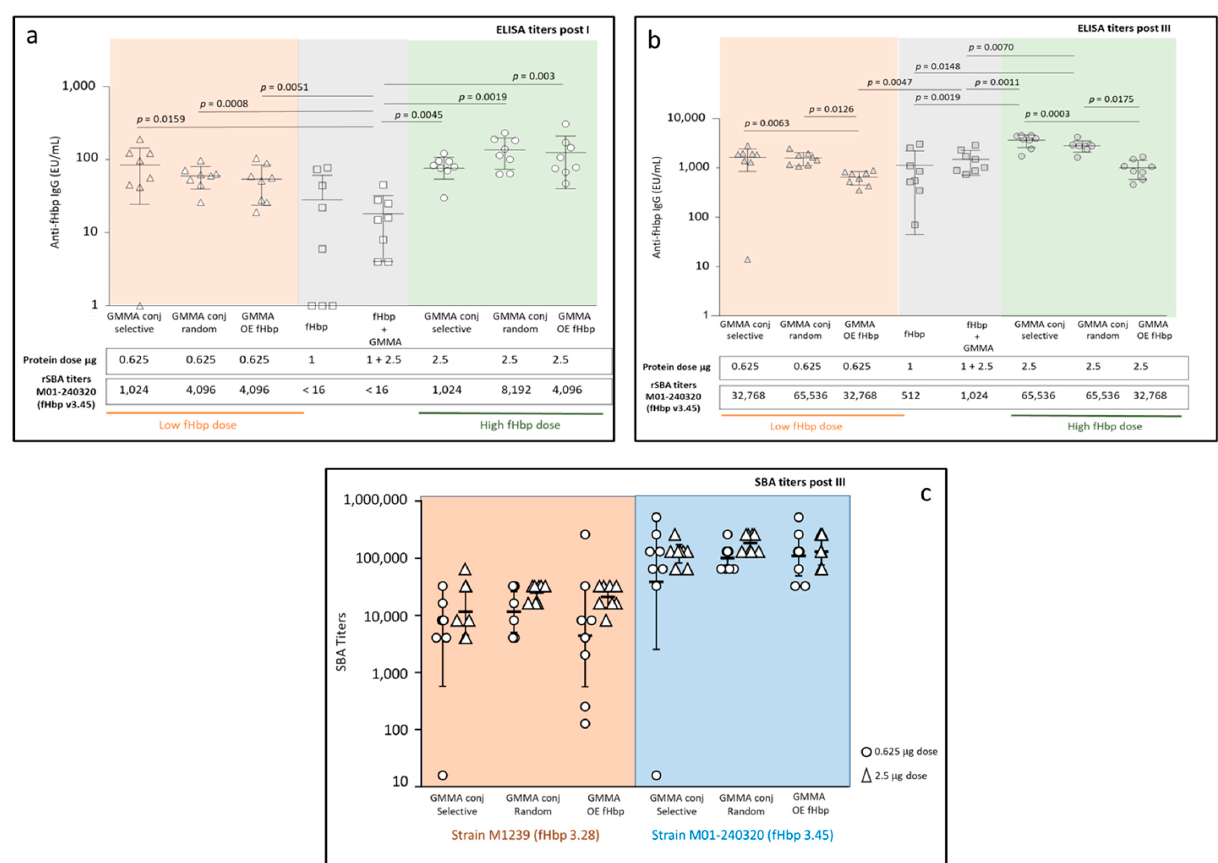
Figure 4. Immunogenicity study of random and selective GMMA-fHbp conjugates compared to GMMA OE fHbp, fHbp alone or physically mixed with GMMA 4KO. Eight 6-week-old female CD1 mice per group were i.p. immunized three times at days 0, 21 and 35. Summary graphs of anti-fHbp IgG response 3 weeks post first immunization ( a ) and 2 weeks after the third immunization ( b ): geometric mean units (bars) and individual antibody levels are reported together with corresponding serum bactericidal assay (SBA) titers of pooled sera for each group against M01-240320 MenB strain, expressing fHbp v3.45; ( c ) SBA titers of individual sera two weeks after the third immunization measured for selected groups against M01-240320 and M1239 MenB strains, expressing fHbp v3.45 and fHbp v3.28, respectively.